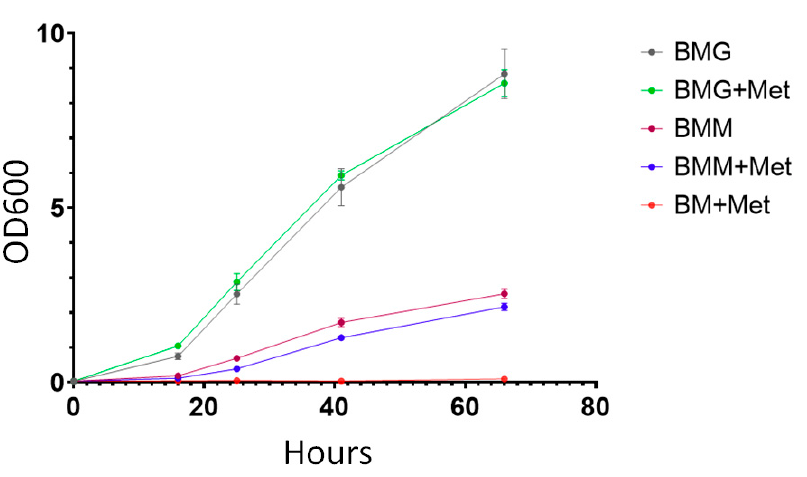
Figure 1. Growth curves of K. phaffii X-33 strain in different media. BMG medium contains 1% glycerol; BMG and Met—1% glycerol and 0.46% L-methionine; BMM—1% methanol; BMM and Met—1% glycerol and 0.46% L-methionine; BM and Met—only 0.46% L-methionine. Cells were grown in four separate cultures for each type of the medium. Each measurement was performed in two replicas for each culture. Mean OD600 values ± SEM are plotted. Raw data is presented in Table S1 in the Supplementary Materials.